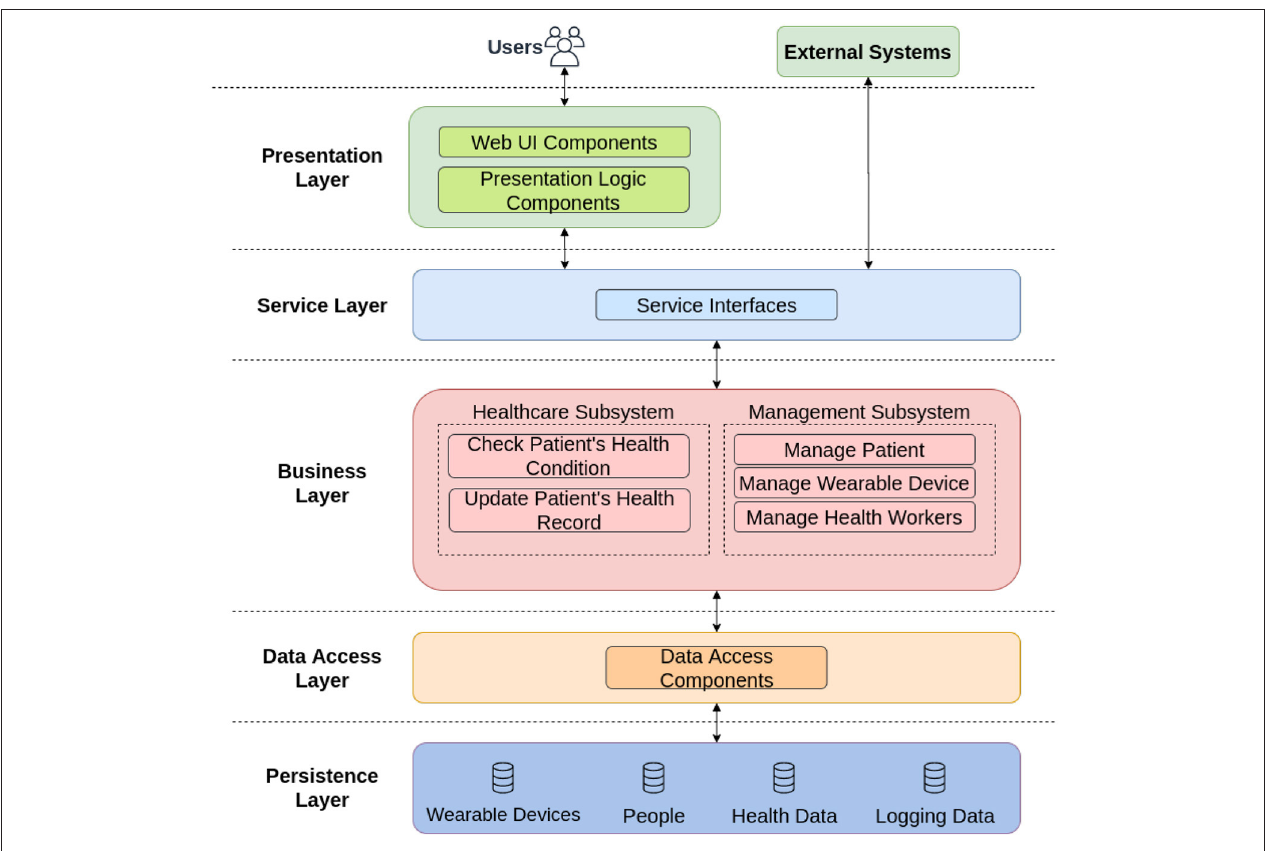
FIGURE 4 | Software architecture for the developed real-time monitoring healthcare